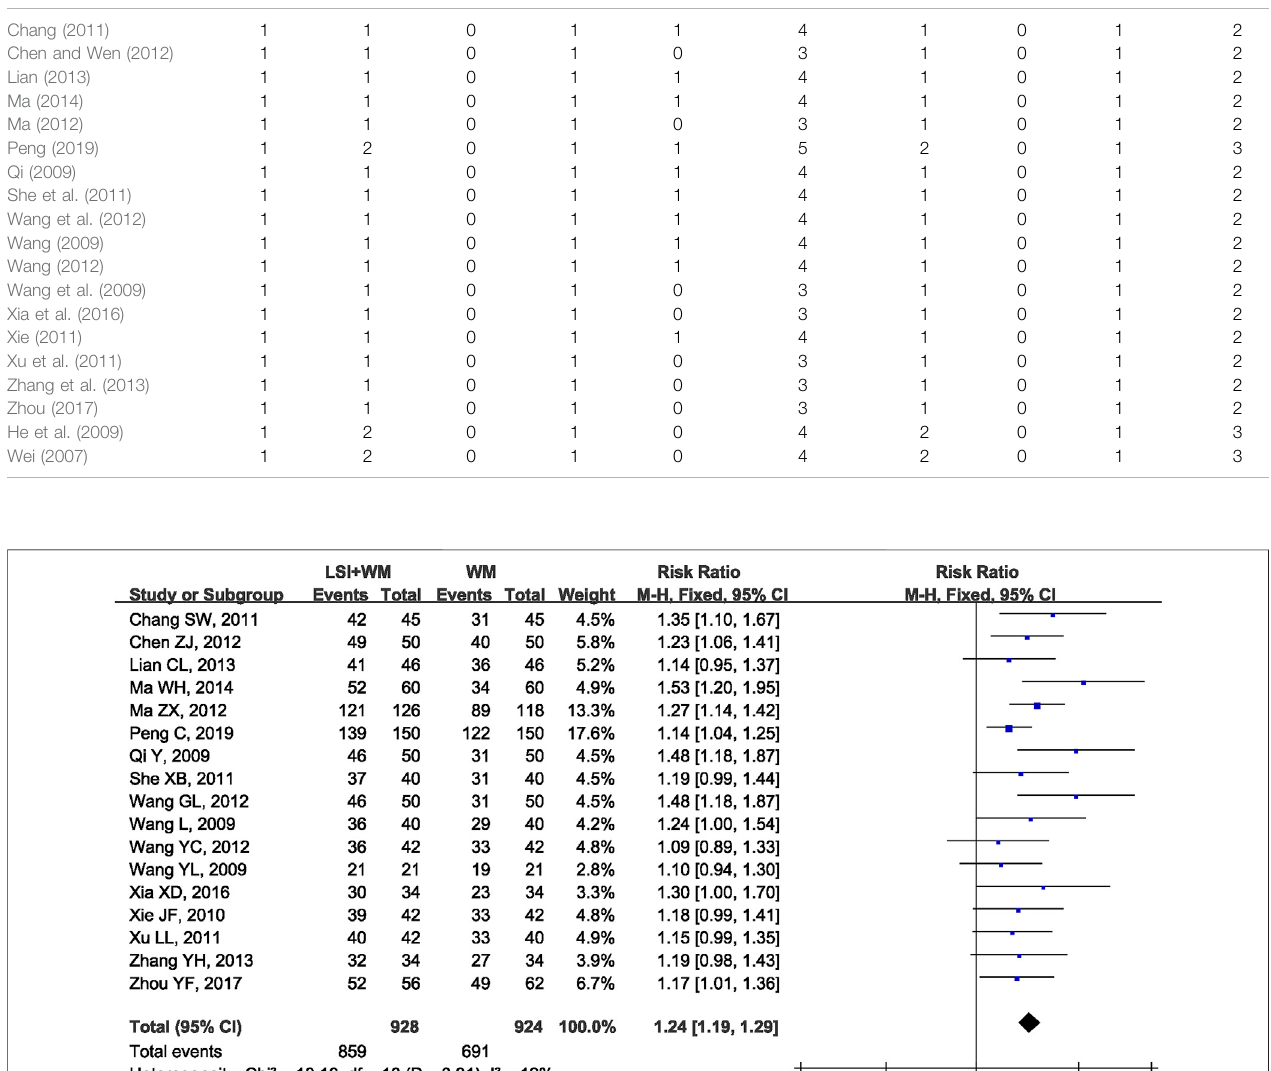
Frontiers in Pharmacology |